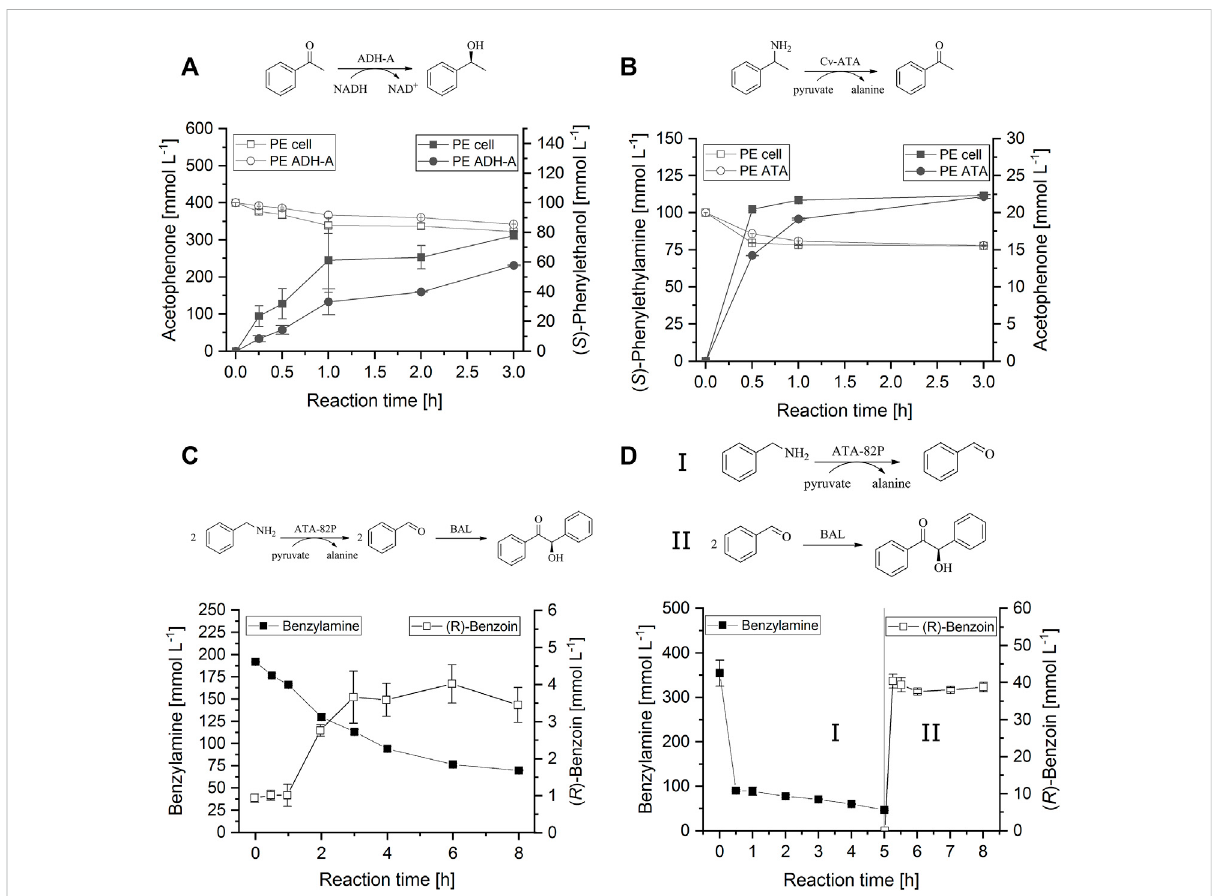
FIGURE 2 Single- and multi-step reactions in w/o PE catalyzed by ADH-A from R. rhodocrous (A) , Cv -ATA from C. violaceum (B) and a combination of commercial ATA-82P (c-Lecta, Germany) and BAL from Pseudomonas fl uorescens Biovar I (C,D) . (A) PE consisting of HEPES buffer in CPME at a volume phase ratio of 1:5 containing 6% (w/v dp ) silica particles. Reduction of acetophenone (empty symbols) to ( S )-1-phenylethanol ( fi lled symbols) with NADH and iso-propanol. (B) PE consisting of HEPES buffer in CPME at a volume phase ratio of 1:5 containing 6% (w/v dp ) silica particles. Deamination of rac -1-phenylethylamine (empty symbols) to acetophenone ( fi lled symbols) using pyruvate as co-substrate. (C) PE consisting of TEA buffer in CPME at a volume phase ratio of 1:3 containing 9% (w/v dp ) silica particles. Deamination of benzylamine with pyruvate as co-substrate, and carboligation of benzaldehyde to ( R )-benzoin inone-pot over time. (D) PE consisting of TEA bufferin CPME ata volume phase ratio of 1:2 with ATA-